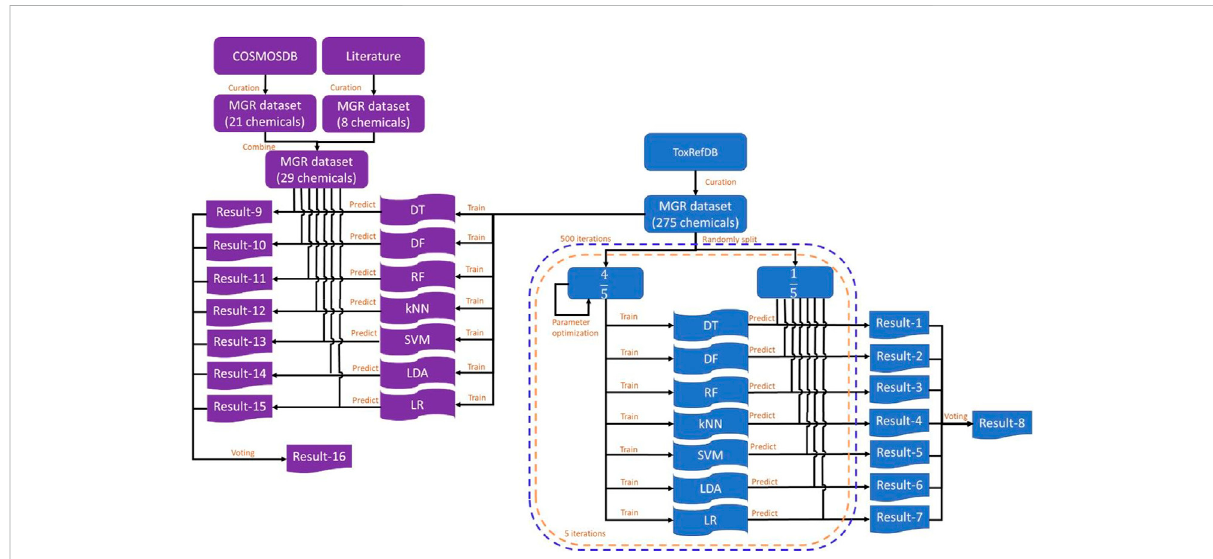
FIGURE 1 Studydesign.Thetraining datasetwascuratedfromToxRefDB andtheexternalvalidationdatasetwascuratedfromtheCOSMOSdatabaseand the literature. The training dataset was randomly split into fi ve folds. Four folds were used to build models using each of the seven machine learning algorithms and the remaining fold was used to evaluate the constructed models. Predictions were recorded in Result-1 to Result-7 and the consensus predictions were generated and recorded in Result-8. This process was repeated fi ve times until each of the fi ve folds was used as a testing setonce and onlyonceto completea5-fold cross-validation. The 5-fold cross-validationwas iterated 500times. The whole training dataset was used to construct models using the same machine learning algorithms and results were recorded in Result-9 to Result-16. MGR: multigeneration reproductive; DT, decision tree; DF, decision forest; RF, random forest; kNN, k-nearest neighbors; SVM, support vector machine; LDA, linear discriminant analysis; LR, logistic